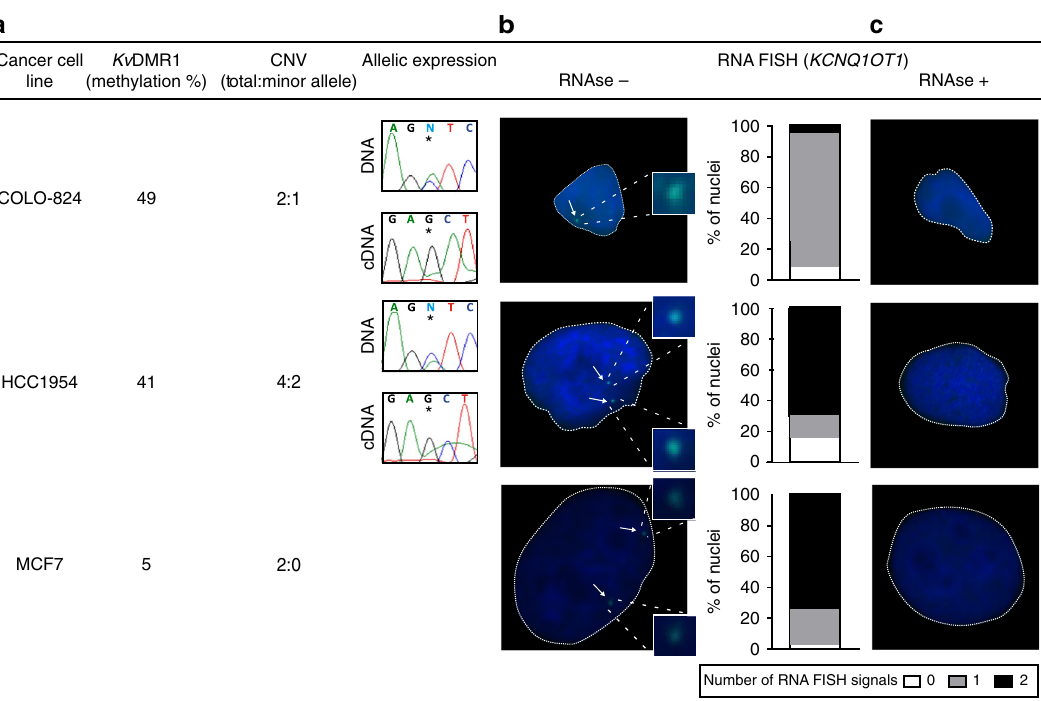
Fig. 4 Allelic expression analysis of KCNQ1OT1 in cancer cell lines. a Three cell lines with different copy-number status (COLO-824, copy number 2:1; HCC1954, copy number 4:2; MCF7 copy number 2:0) were assessed by Sanger sequencing of rs231359 polymorphism in the KCNQ1OT1 transcript in DNA and cDNA, respectively. The average methylation of the Kv DMR1 was determined from In fi nium HM450k array data. b Representative RNA-FISH analysis of KCNQ1OT1 lncRNA-coated territory (green signal, white arrows) of individual nuclei with inserts representing zoomed in images of FISH signals. Nuclei were stained with DAPI. The quanti fi cation of KCNQ1OT1 expression signals represented as stacked bar charts indicates the percentage of nuclei displaying the indicated number of expression foci. c KCNQ1OT1 RNA-FISH performed on cells retreated with RNAse